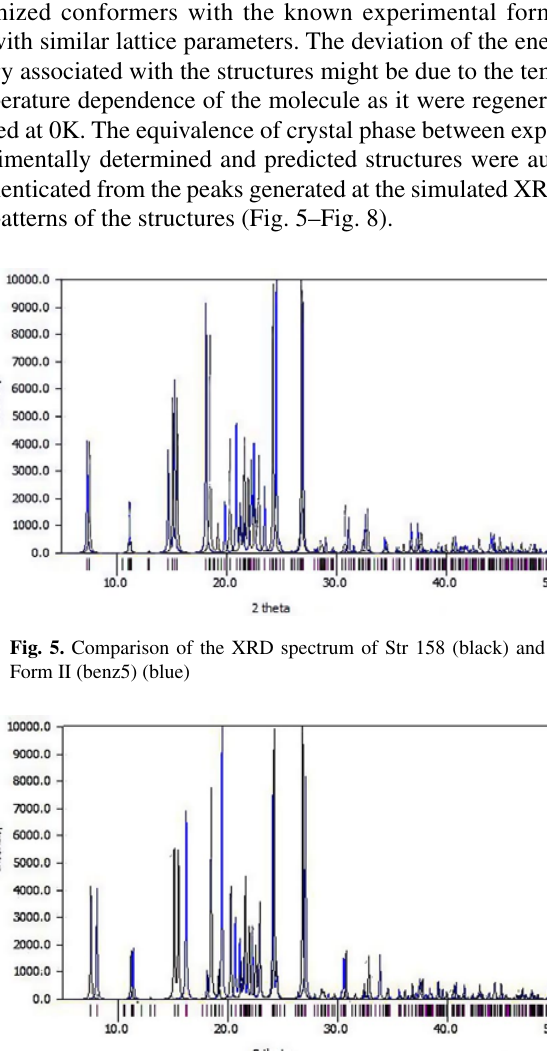
Fig. 8. Comparison of XRD spectrum of Str 362 (black) and Form I